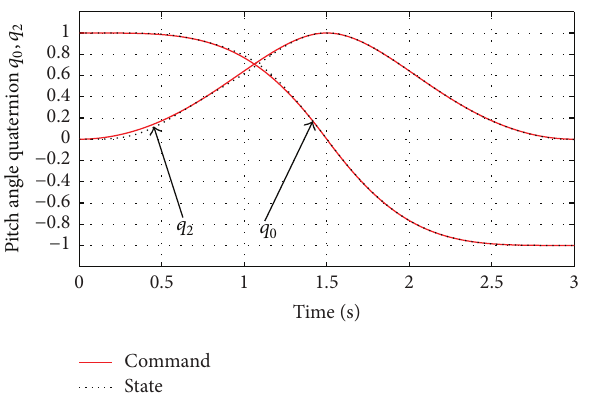
Figure 10: Command and state quaternion for a clothoid loop.